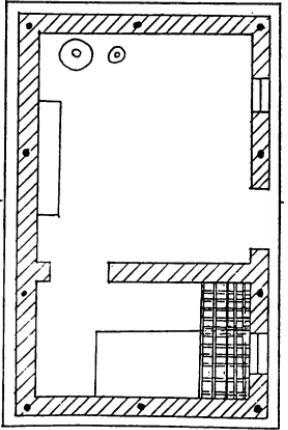
Figure 13ii. Plan of a Family Unit, Source Nsude,